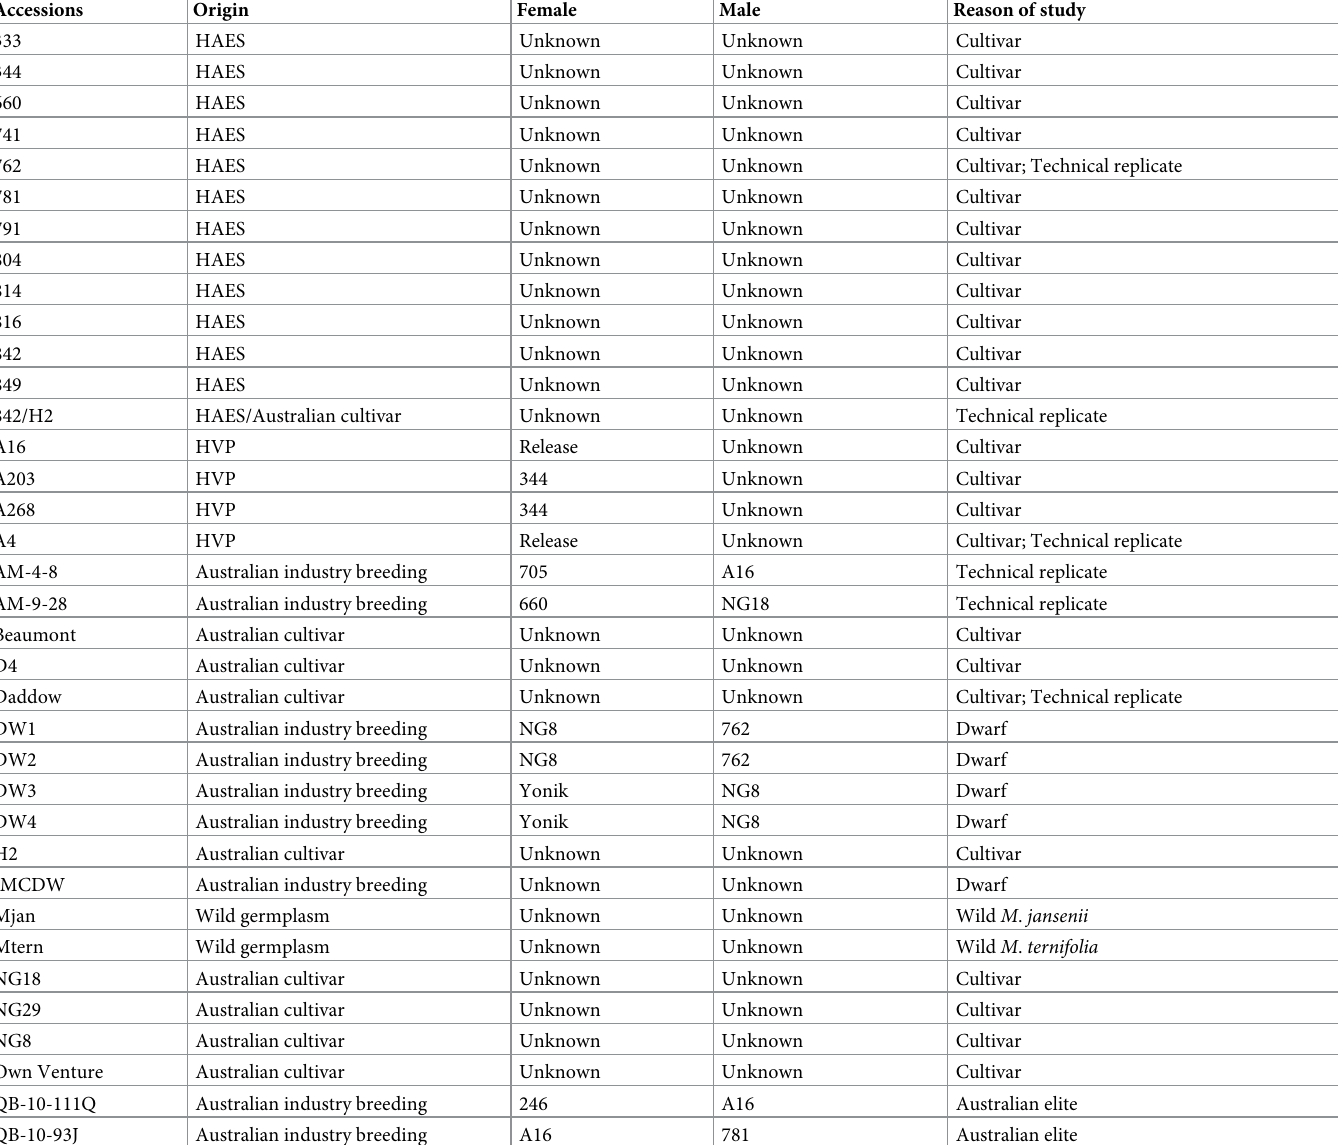
Table 1. List of macadamia cultivars used in genetic diversity study. HAES Hawaiian Agricultural Experiment Station; HVP Hidden Valley